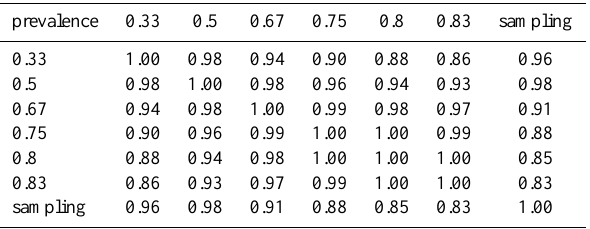
Table 1. Correlation (all species combined) among predicted prob- abilities for varying modeling prevalences at a constant sample size of present cases and sampling prevalence (mean sampling preva- lence = 0.28, range =